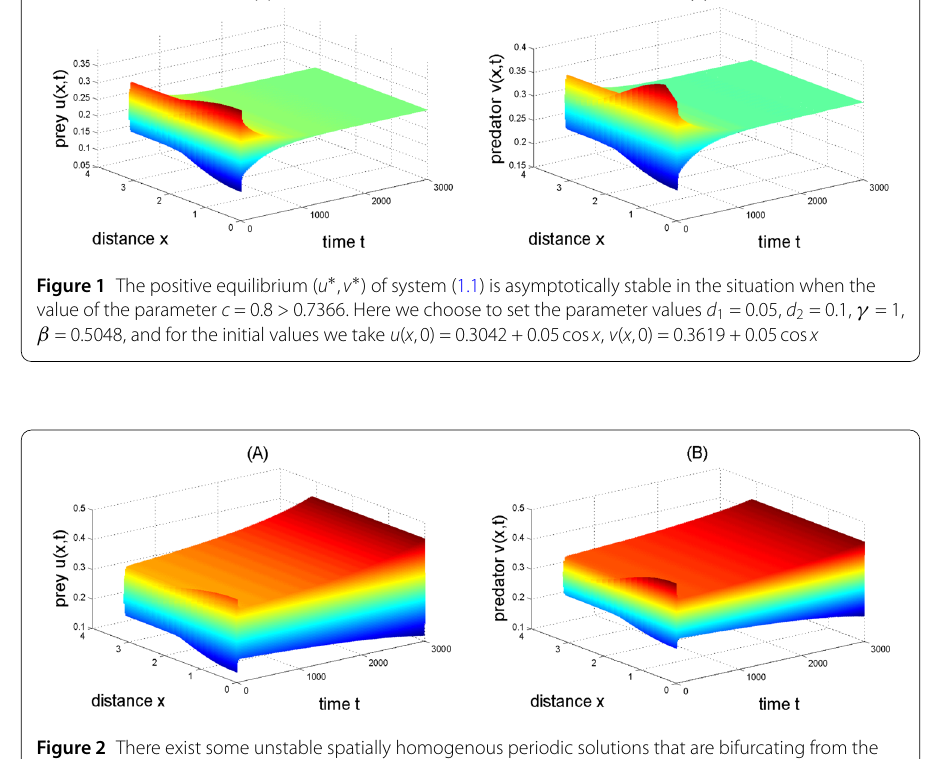
Figure 2 There exist some unstable spatially homogenous periodic solutions that are bifurcating from the positive equilibrium ( u ∗ , v ∗ ) of system (1.1) when the parameter c = 0.75 > 0.7366. Here we choose to set parameter values as d 1 = 0.05, d 2 = 0.1, γ = 1, β = 0.5048, and for the initial values we take u ( x ,0) = 0.3042 + 0.05cos x , v ( x ,0) = 0.3652 + 0.05cos